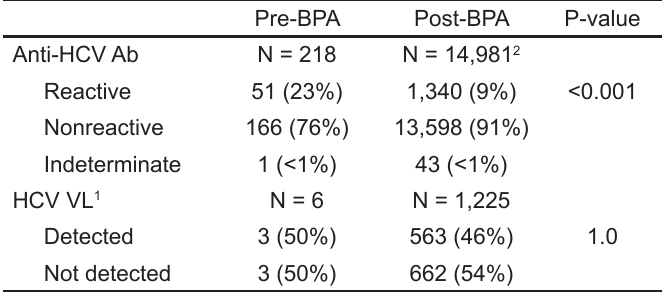
Table 2. Hepatitis C virus test results by screening